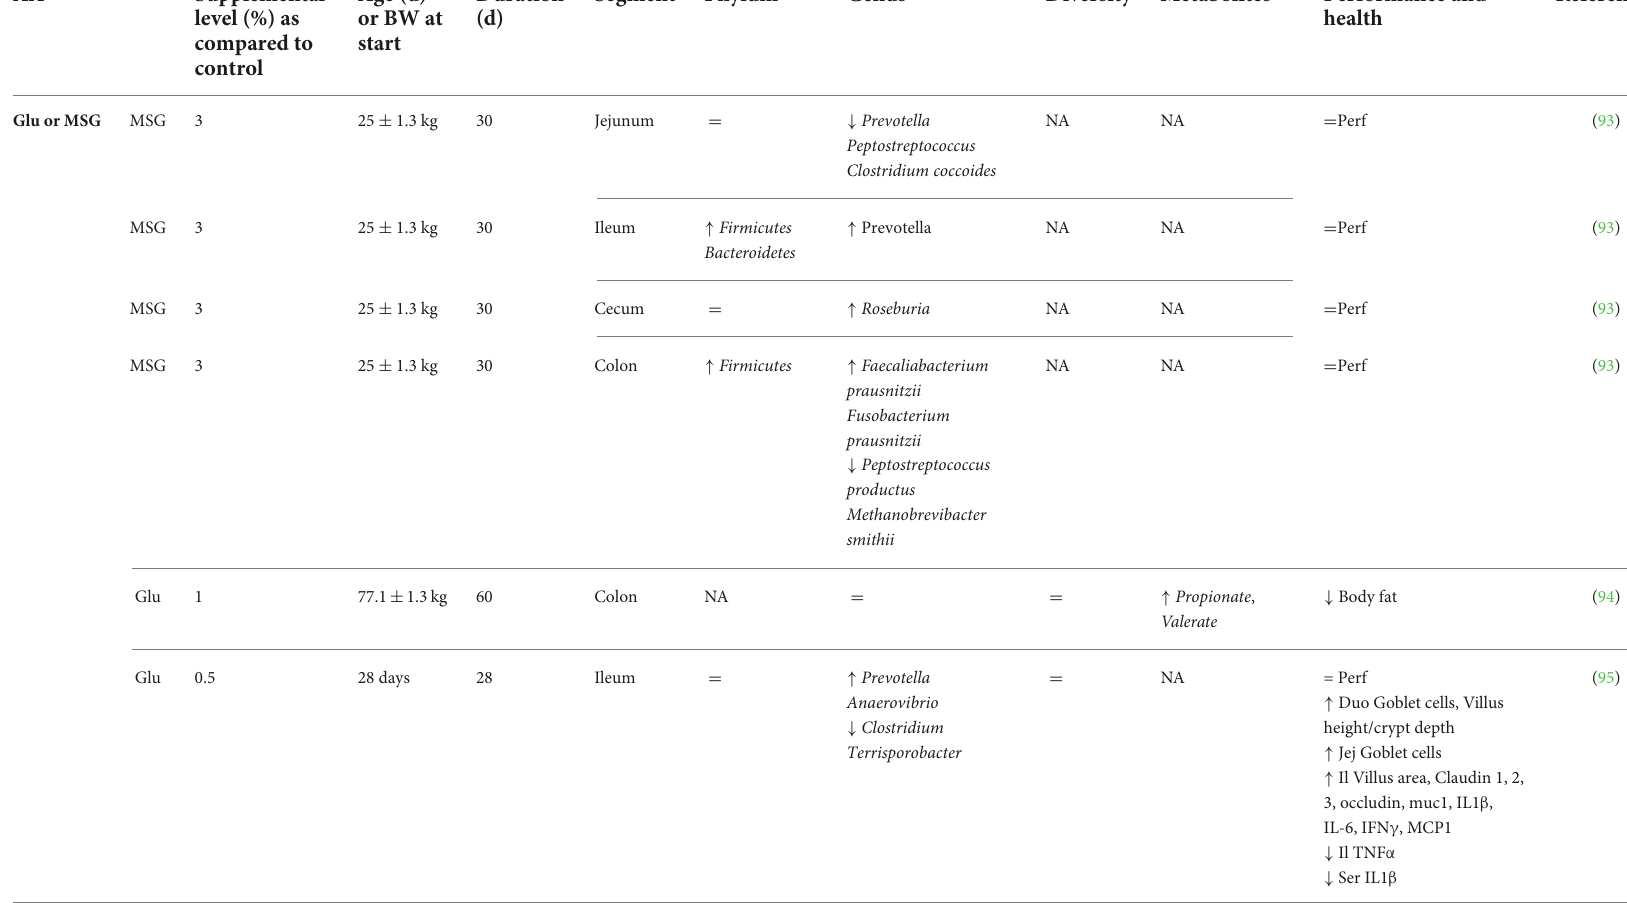
TABLE 3 Effect of free amino acid supplementation on microbiota, performance and health outcomes in